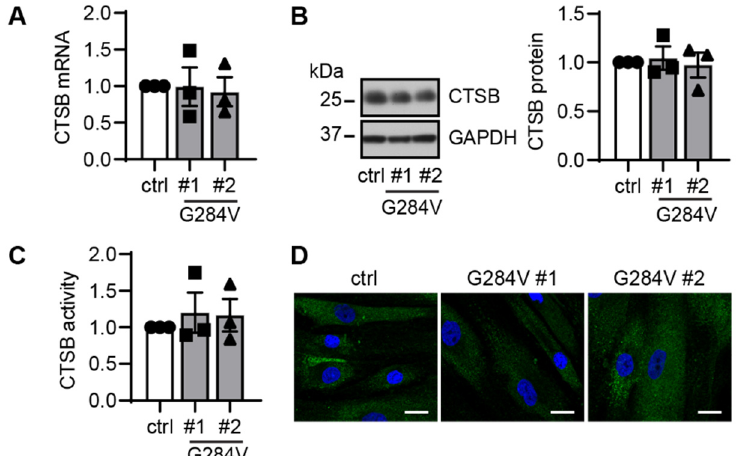
Figure 4. Functional analysis of CTSB in patient-derived skin cells. ( A ) qRT-PCR showed comparable mRNA levels in both CTSB mutant fibroblasts and the controls cells. ( B ) Representative western blot images of control and two CTSB mutant fibroblast lines (left). Western blot quantification showed similar levels of total CTSB protein levels in both CTSB mutant, and the WT control cells (right). ( C ) CTSB activity assay using cell lysates showed no differences in total enzymatic activity in the mutant fibroblast compared to the control. Circle—control, square—patient #1 carrying CTSB G284V, triangle—patient #2 carrying CTSB G284V. ( D ) Representative images of CTSB immunofluorescence staining (green) in fibroblasts at baseline condition. Scale bar: 20 µm. n = 3 independent experiments. Data are normalized to set control as 1 and are shown as mean with standard error. One-way